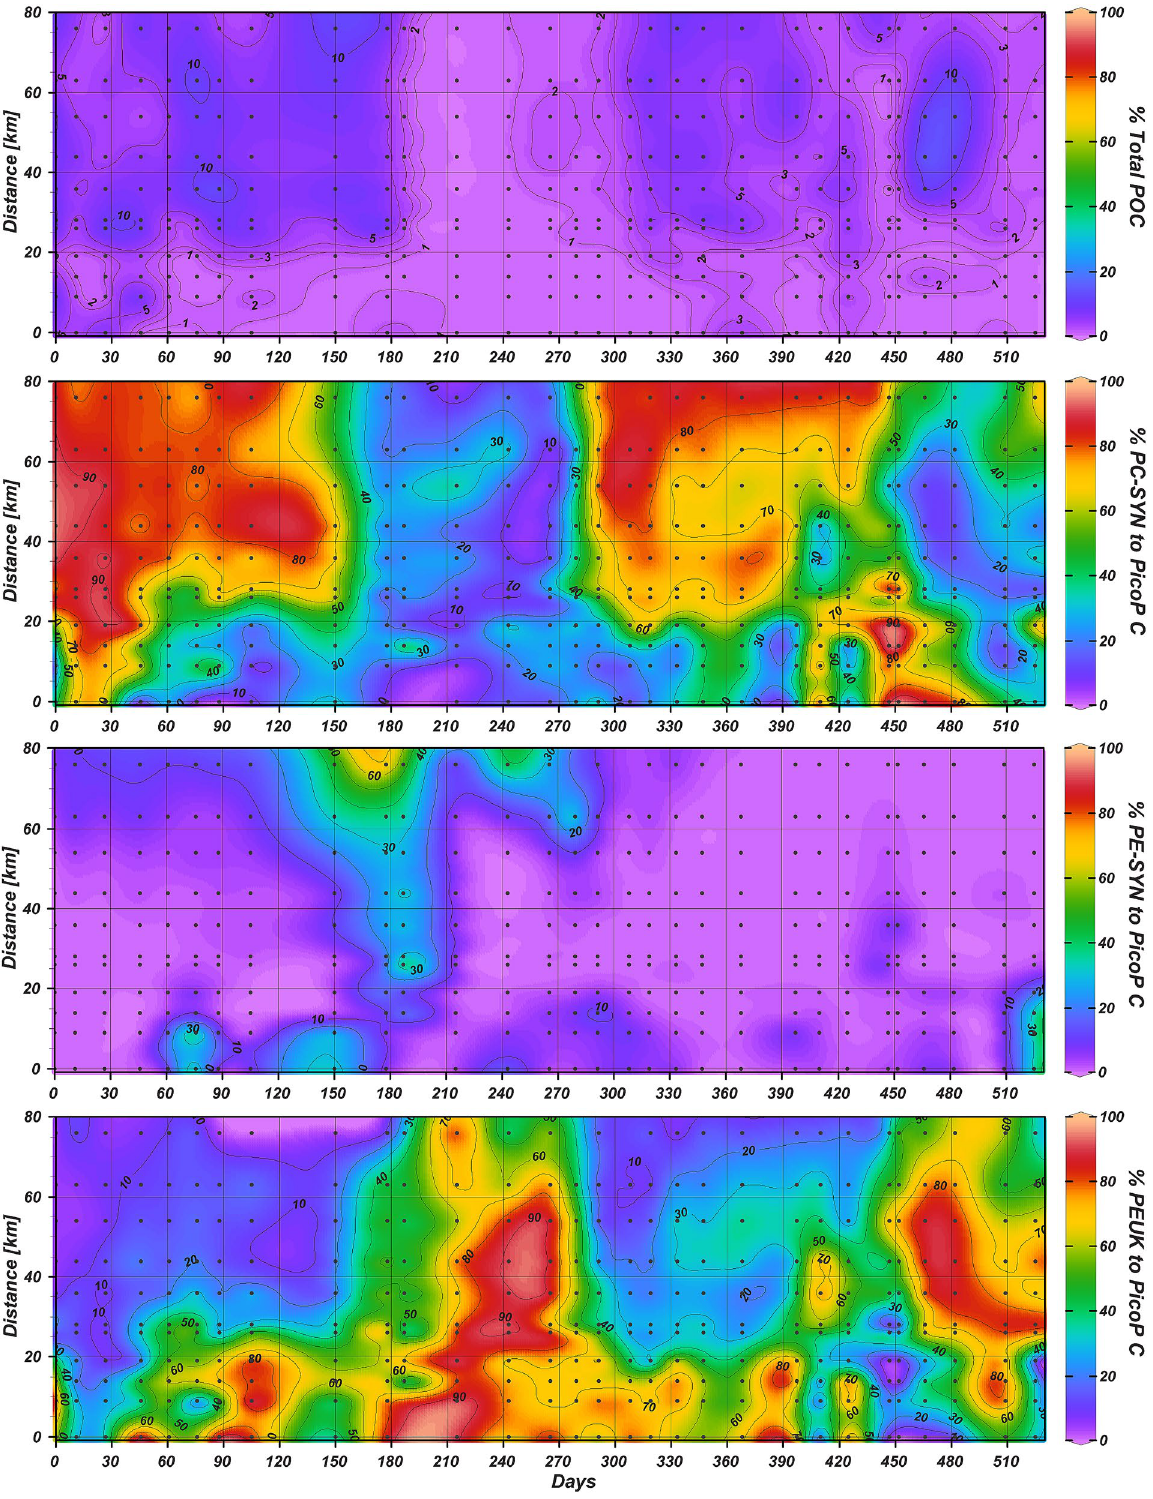
Figure 5. Percent contribution of PicoP to POC, as well as, percent contribution of individual PicoP morphotypes to total PicoP organic